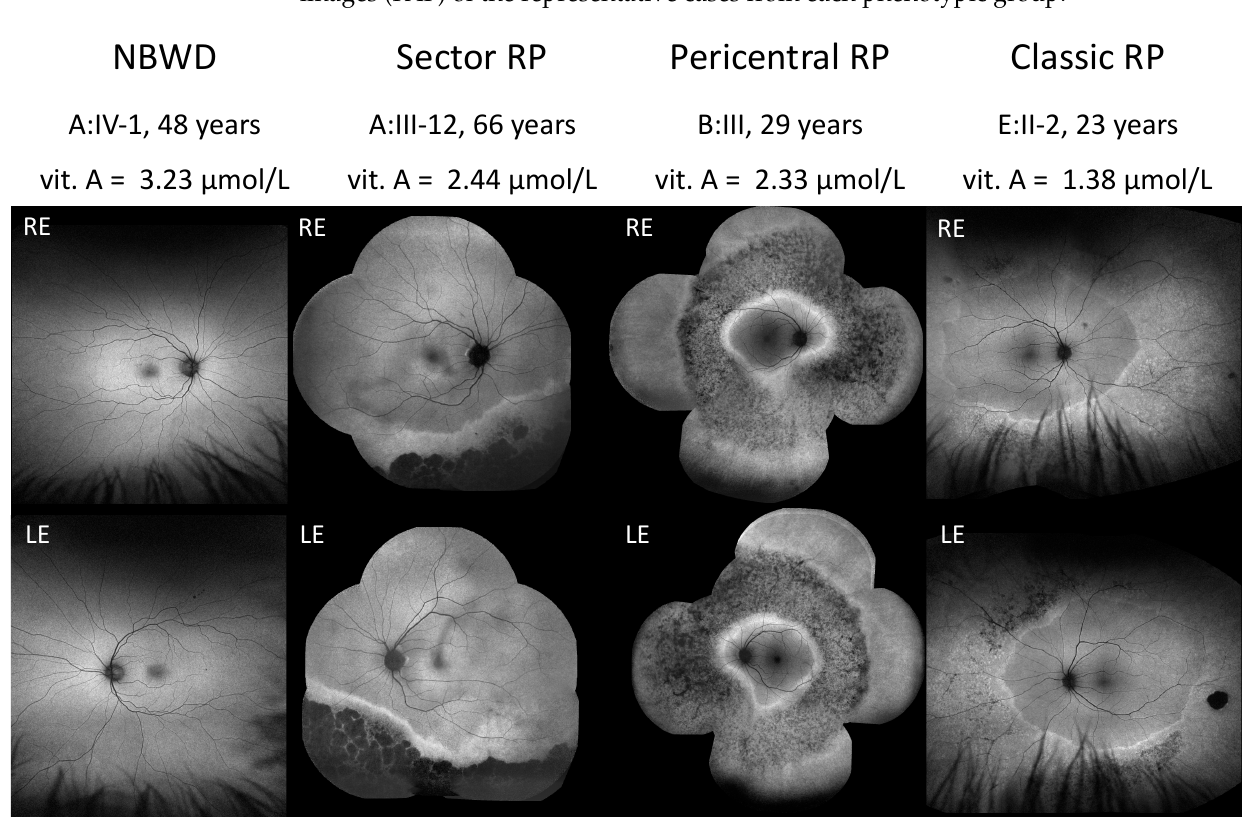
Figure 1. Representative cases from each phenotypic group. NBWD—night blindness without degeneration; RP—retinitis pigmentosa; vit. A—serum concentration of vitamin A; RE —right eye; LE—left eye.